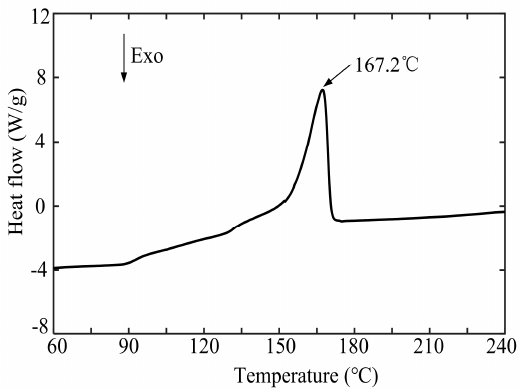
Figure 2. The differential scanning calorimetry (DSC) heating curve of the polymer particles. 114